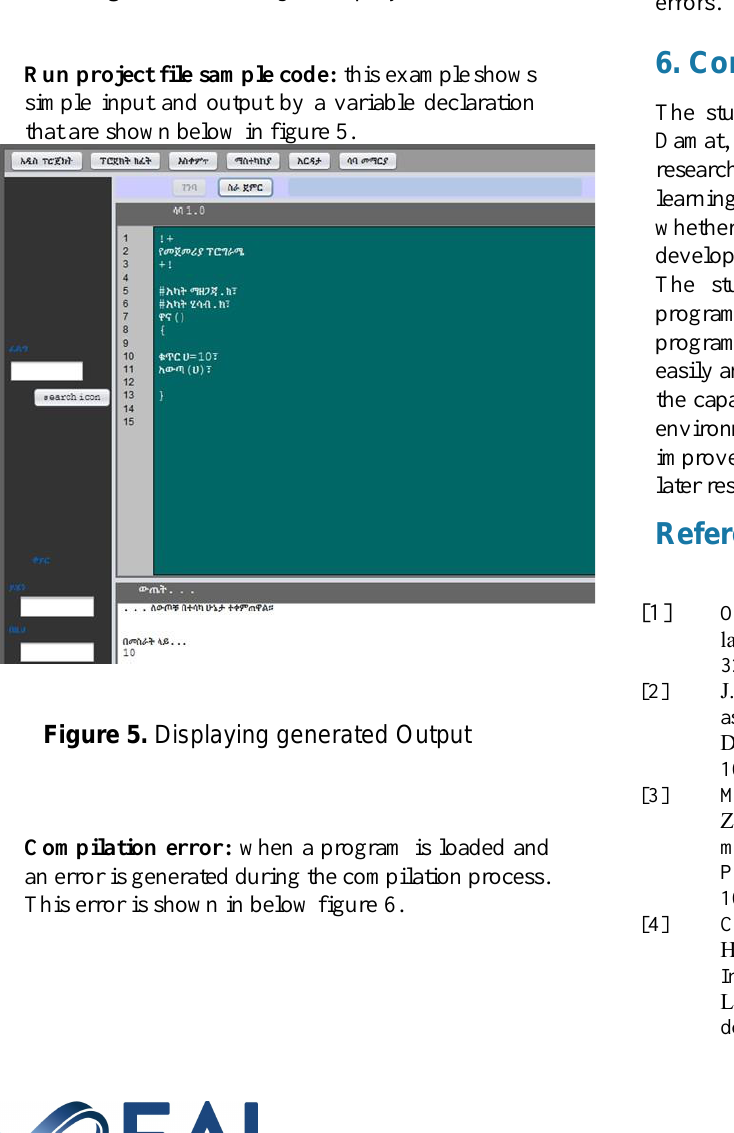
Figure 4. Creating New project